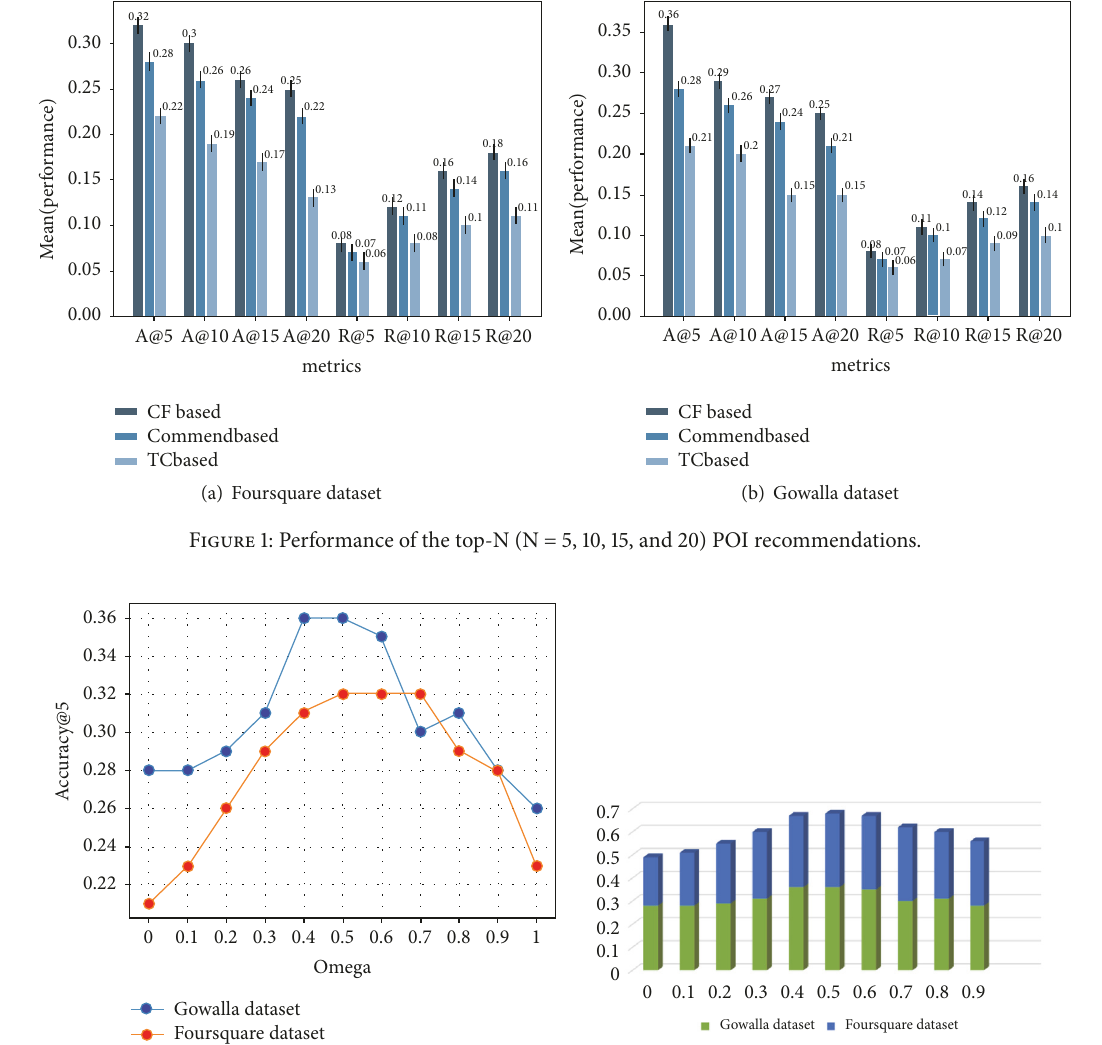
algorithm may yield suboptimal prediction, due to the dif- ferences in the length of travel